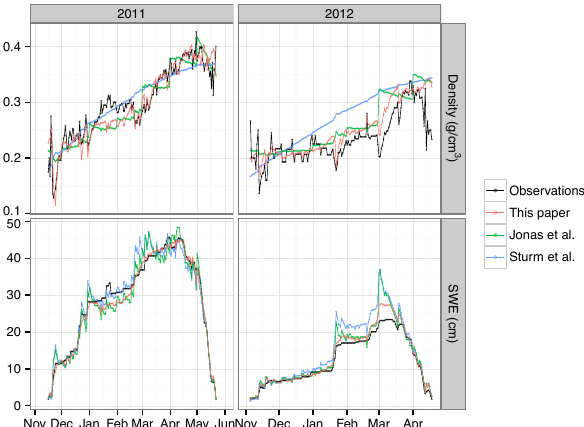
Fig. 5. Examples of observed and modeled density and SWE time series in two water years at SNOTEL site 1145 Kilfoil Creek, UT. Depth and density values for depths less than 1.27cm (0.5in) are suppressed from the